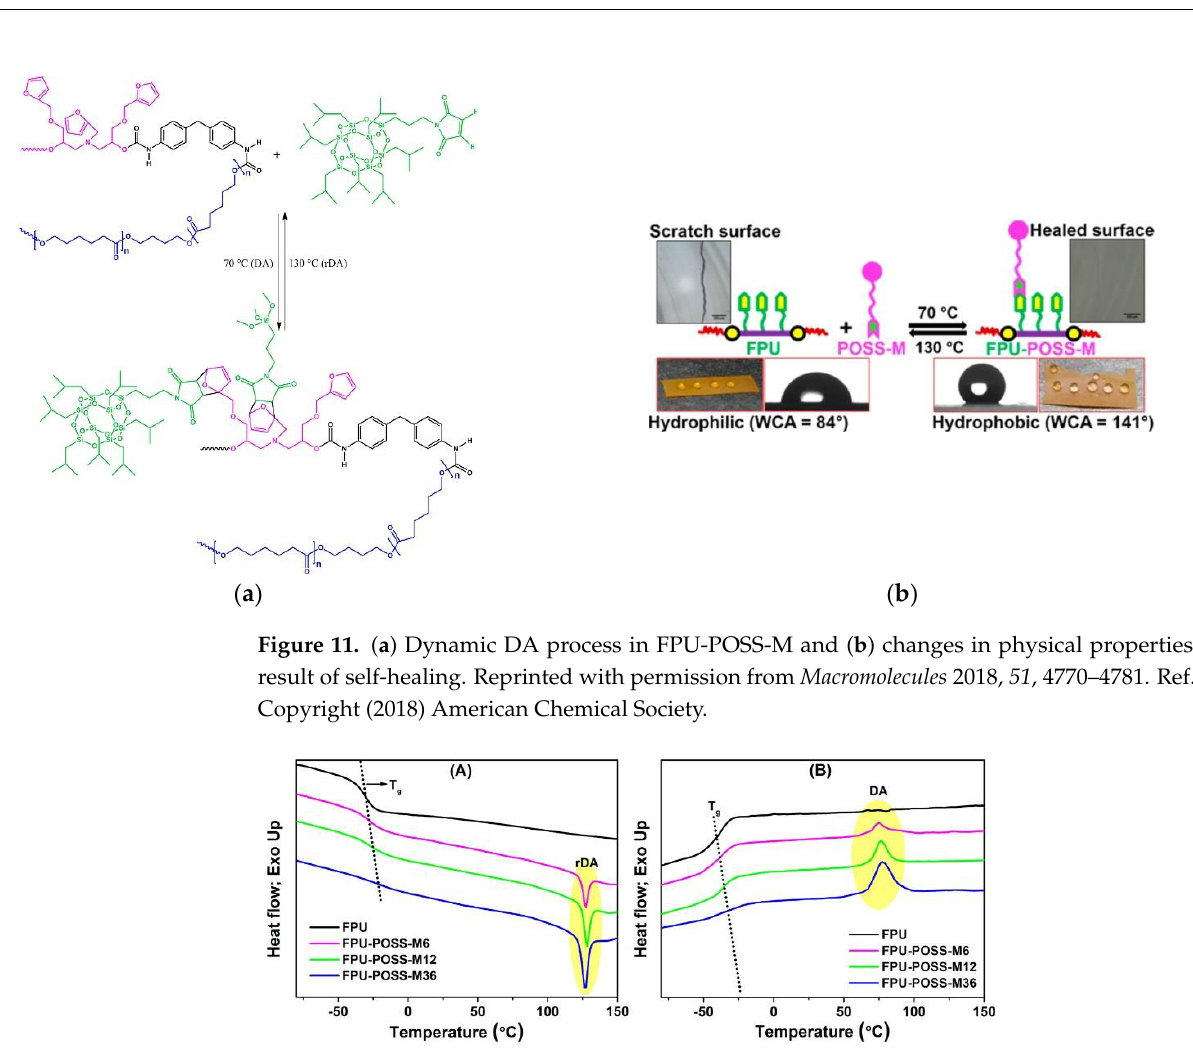
Figure 12. DSC heating ( A ) and cooling ( B ) thermograms of native FPU and hybrid composites FPU- POSS-M6, FPU-POSS-M12, and FPU-POSS-M36. Reprinted with permission from Macromolecules 2018, 51 , 4770 – 4781 [74] Copyright (2018) American Chemical Society.